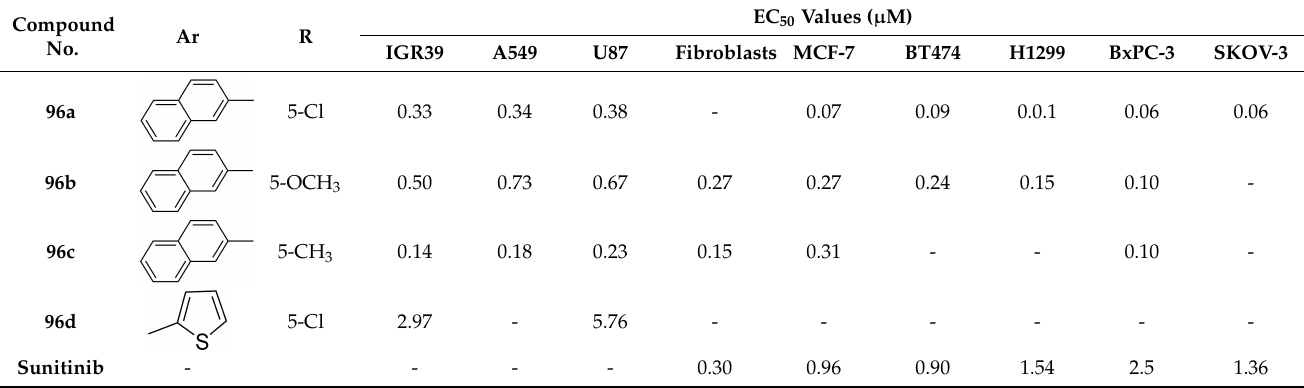
Table 83. In vitro cytotoxic activities of isatin-dihydropyrazole hybrid compounds 96 ( a – d ). Compound